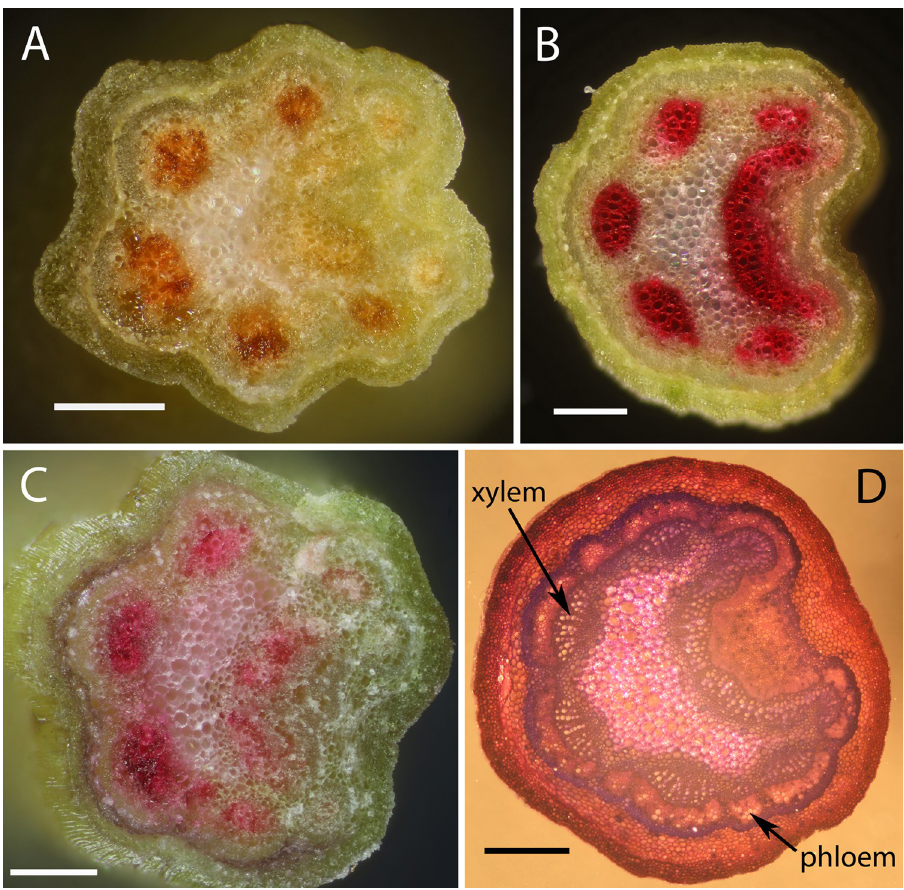
Fig 5. Petioles of sugar maple ( Acer saccharum ) with xylem stained by Symmerista leucitys saliva or dye. (A) Petiole clipped by a S . leucitys larva, then severed with a razor blade 2.5 mm from the stub tip approximately five minutes after the larva finished applying saliva. The red salivary pigment moved into the petiole staining the xylem. (B) Petiole xylem stained by safranin O dye (0.2%) pulled up the xylem by transpiration. (C) Petiole stub treated with 1 μ l safranin O dye (0.2%). After 5 minutes, the petiole was severed 2.5mm from the initial cut. The dye moved in a retrograde direction down the xylem staining the same tissues as Symmerista pigment in (A) and dye in (B). The petiole slices in A-C were photographed dry to prevent pigment and dye from dissolving or spreading to adjacent tissues. (D) Thin slice of petiole stained with toluidine blue followed by safranin O to show the location of xylem and phloem. Scale bars equal 0.2 mm in A-C and 0.5mm in D. The dorsal surface of the petioles is on the right